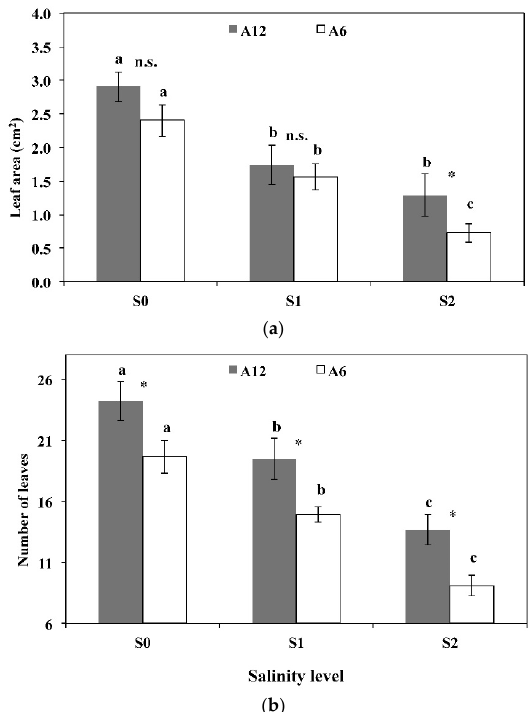
Figure 4. Leaves per plant (n) and leaf area (cm 2 ) in response to different salinity levels (S0, S1, and S2) of two accessions A6 and A12. a–c: the letters denote statistically significant differences